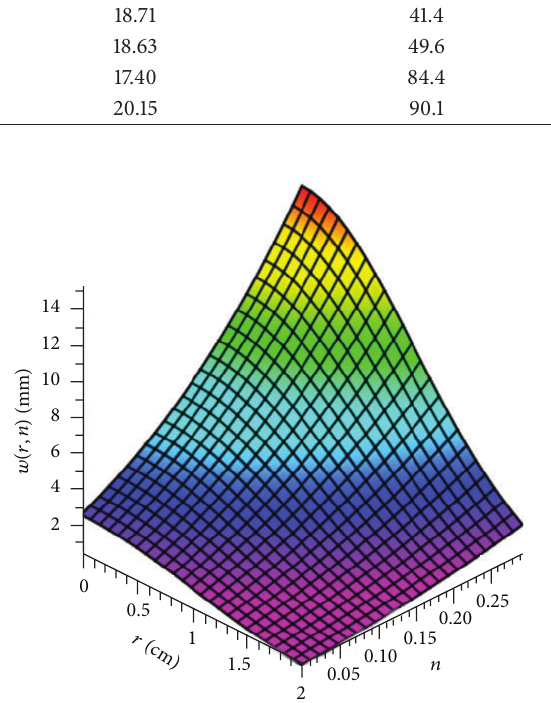
Figure 6: Deformation 𝑤 in function of the radial distance 𝑟 and the hardening exponent 𝑛